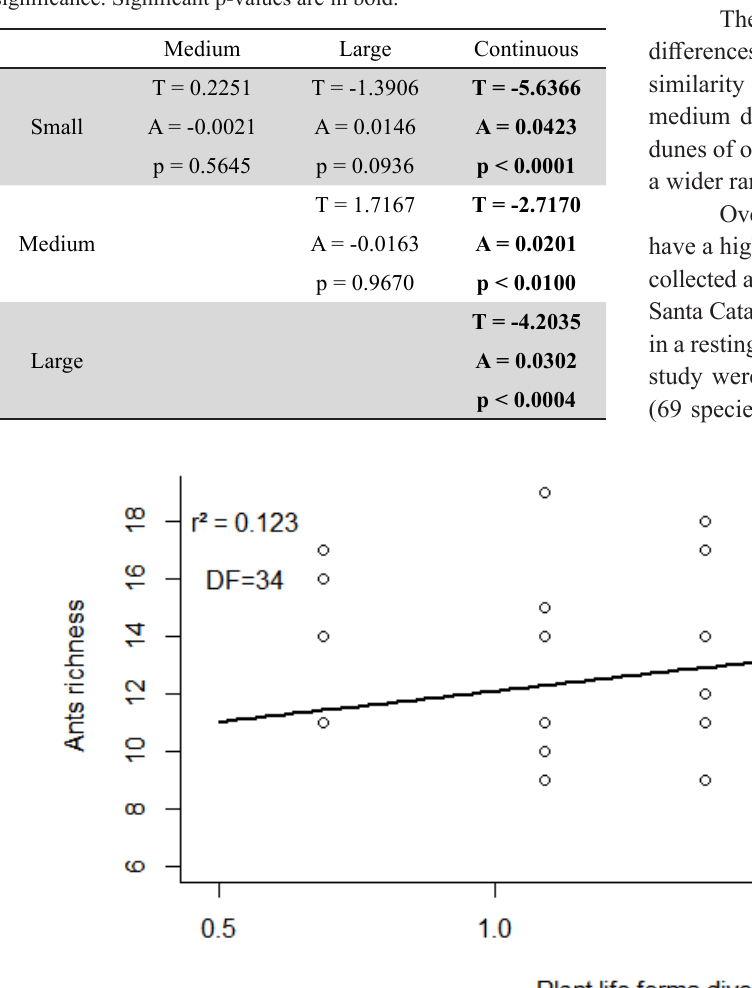
Table 5 . Pairwise comparison of ant communities similarity. T = variation between groups, A = intra-group variation, p = statistical significance. Significant p-values are in